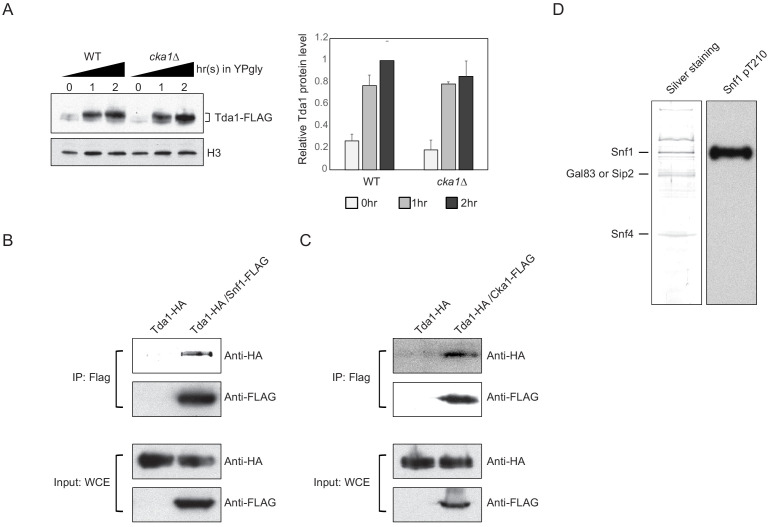
Snf1 phosphorylates Tda1 at C-terminus.(A) (Left panel) Tda1-3xFLAG protein level changes in WT and cka1Δ upon media shift from YPD to YPgly measured by western blot against FLAG tag. (Right panel) The relative band intensities of Tda1 to H3 with error bars indicating STD from three biological replicates. (B and C) Tda1 co-immunoprecipitation assay using (B) FLAG-tagged Snf1 or (C) FLAG-tagged Cka1 as a bait in YPgly media. Immunoprecipitated Tda1 was detected by western blot against HA tag. Tda1-HA strain without any FLAG-tagged protein was used as a negative control. (D) The silver staining (left panel) or western blot against Snf1 pT210 (right panel) of yeast FLAG purified Snf1 from reg1Δ background.